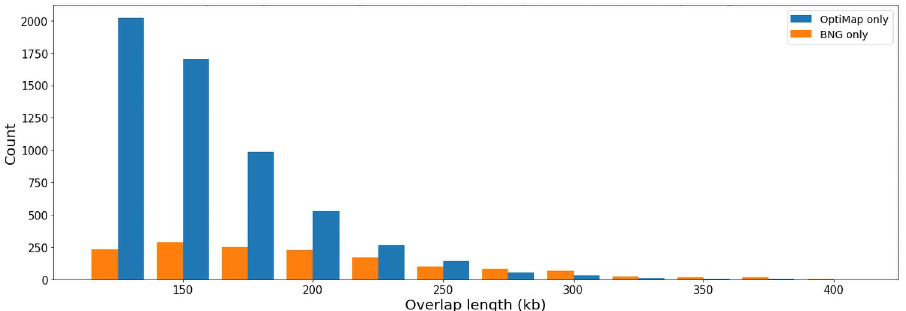
Fig 9. Distribution of alignment overlap lengths for pairs aligned only by either of the